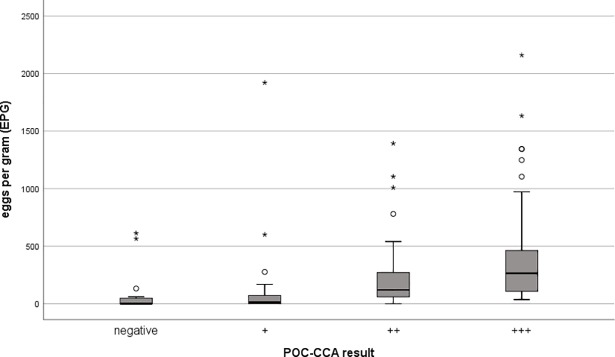
shows that the number of eggs per gram (EPG) of the KK test correlates positively with the intensity of POC-CCA test band (Spearman's correlation coefficient = 0.57; p < 0.001).